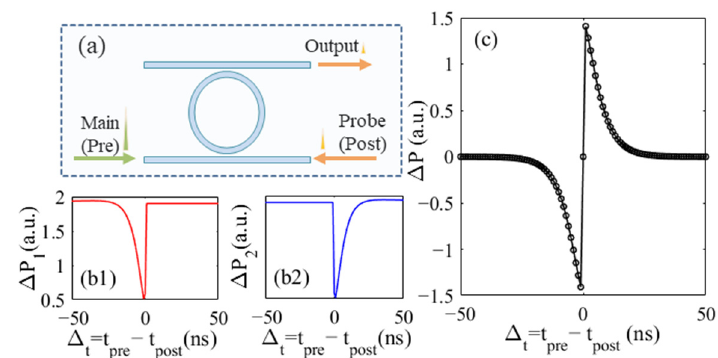
Figure 5. ( a ) MRR-based STDP structure; ( b1 , b2 ) the output power change as a function of ∆ t ; ( c ) the Figure 5. ( a ) MRR ‐ based STDP structure; ( b1 , b2 ) the output power change as a function of calculated STDP transfer the calculated STDP transfer function. Table 2. Basic Parameters Used in MRR STDP. Parameter